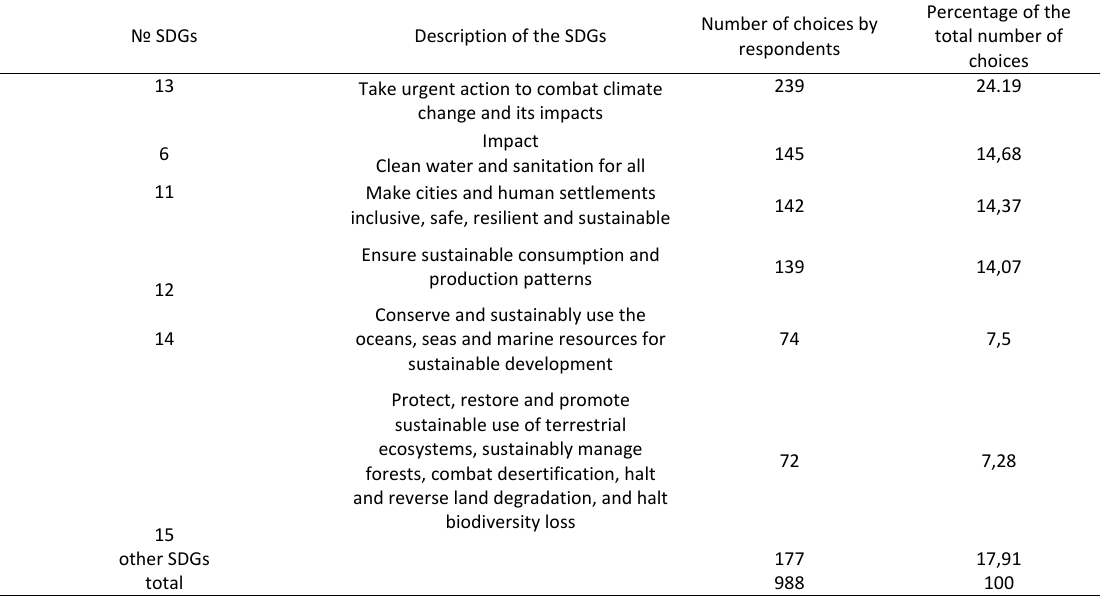
Table 1: Multiple‐choice question of the respondents (no more than 5 of 17 SDGs)